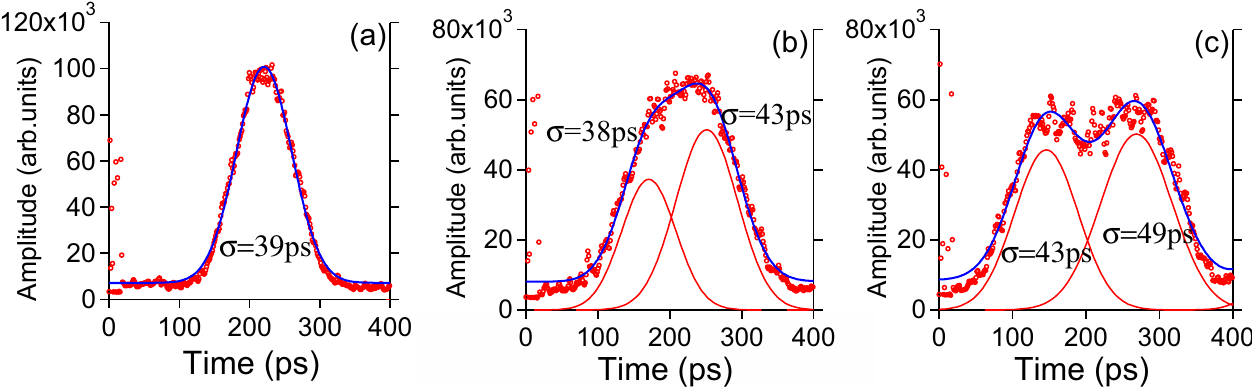
FIG. 16. (Color) Average bunch profile with the corresponding best fitting curves in case of a uniform filling for a 3HC detuning of (cid:1) 315 mA , 2.0 (cid:7) 114 kHz (a), (cid:7) 74 kHz , (b), and (cid:7) 61 kHz (c); I beam